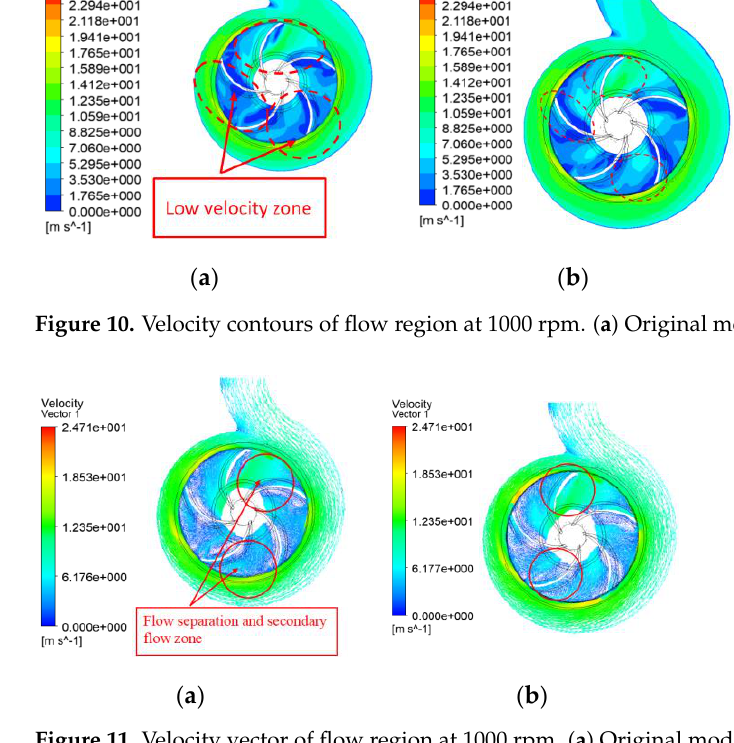
( b ) Figure 12. Pressure contours of flow region at 1250 rpm. ( a ) Original model; ( b ) rounded model.